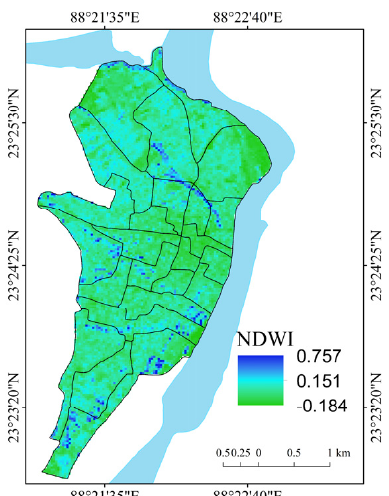
Figure 21. NDWI (2000).